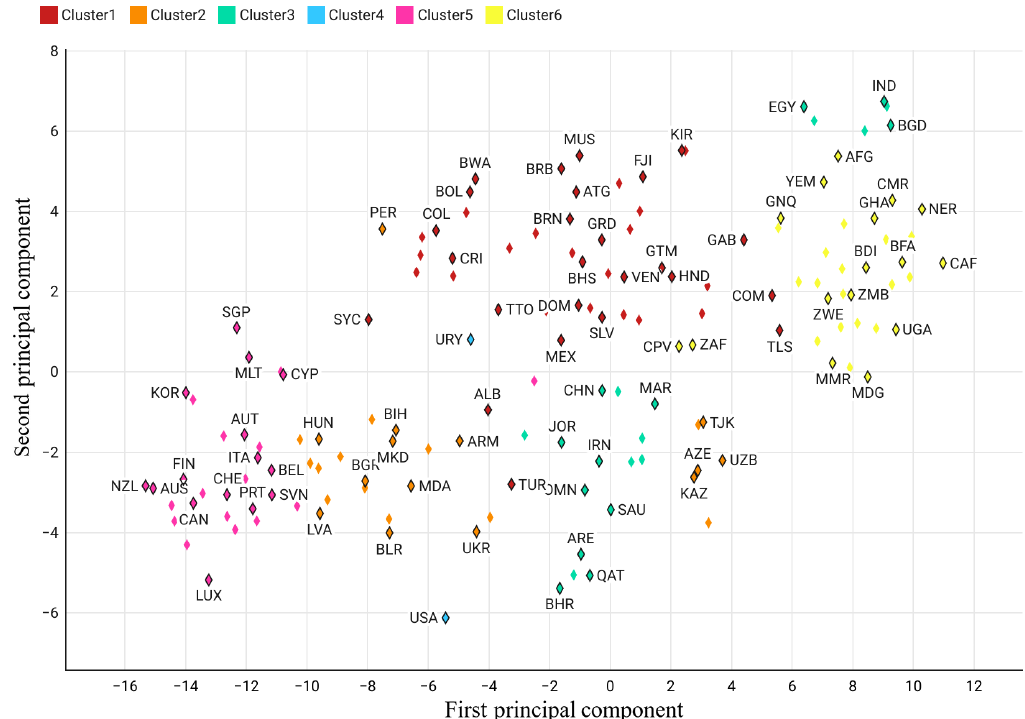
Fig. 9 COVID-19 country clustering based on a six-cluster spectral clustering algorithm. Different colors represent different clusters. Only 156 countries and regions (labelled according to ISO 3166) were selected for analysis, some of which were unlabeled mainly due to limited